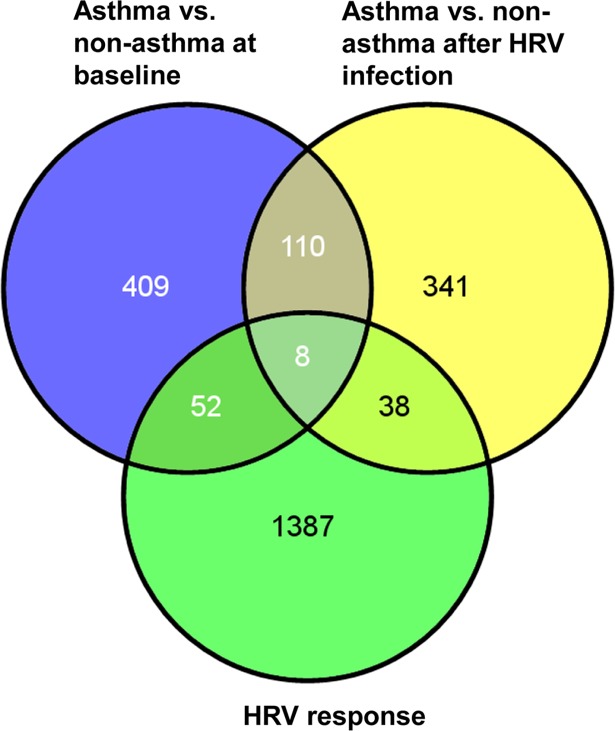
Distributions of differentially expressed genes in asthmatic samples after treatment of vehicle or RV-A16.579 genes in the “Asthma vs. non-asthma at baseline” group had baseline difference between asthmatic and non-asthmatic cells (p<0.05); 497 genes in the “Asthma vs. non-asthma after HRV infection” group had asthma-related viral response (p<0.05); and 1485 genes in the “HRV response group had strong expression changes associated with viral infection across both asthma and non-asthma donors. The numbers of genes only in one group or common for either two or three groups are shown by either exclusive or overlapping areas in Venn diagrams. The diagrams were generated with an online tool available at http://bioinfogp.cnb.csic.es/tools/venny/.